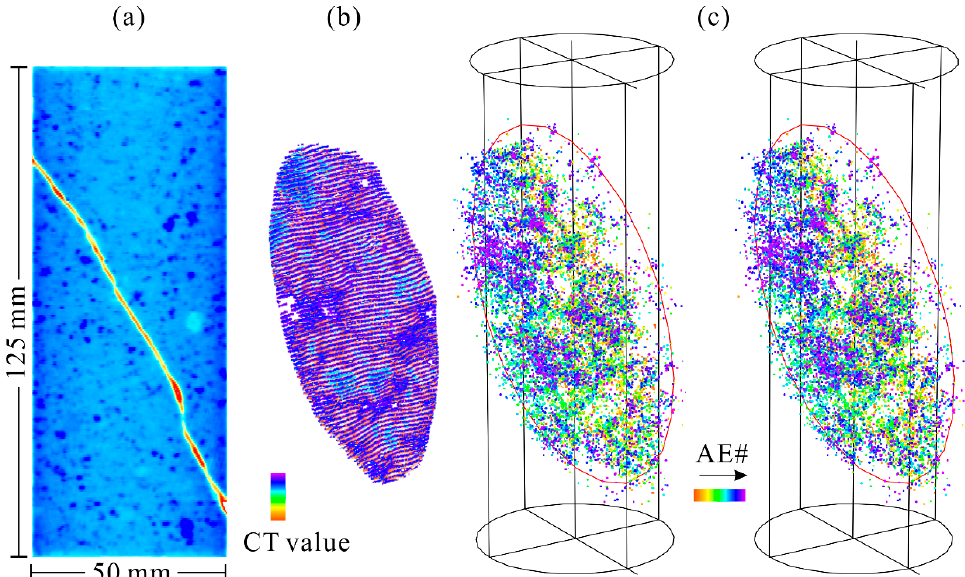
Figure 5. ( a ) Vertical section of three-dimensional X-ray computed tomography (CT) scan performed after the experiment. The fracture zone is characterized by very low CT value. ( b ) Three-dimensional fracture surface. ( c ) Stereo plots of well-determined (by at least 12 P arrival times) AE hypocenters. Hypocenter dots are colored according to event number.